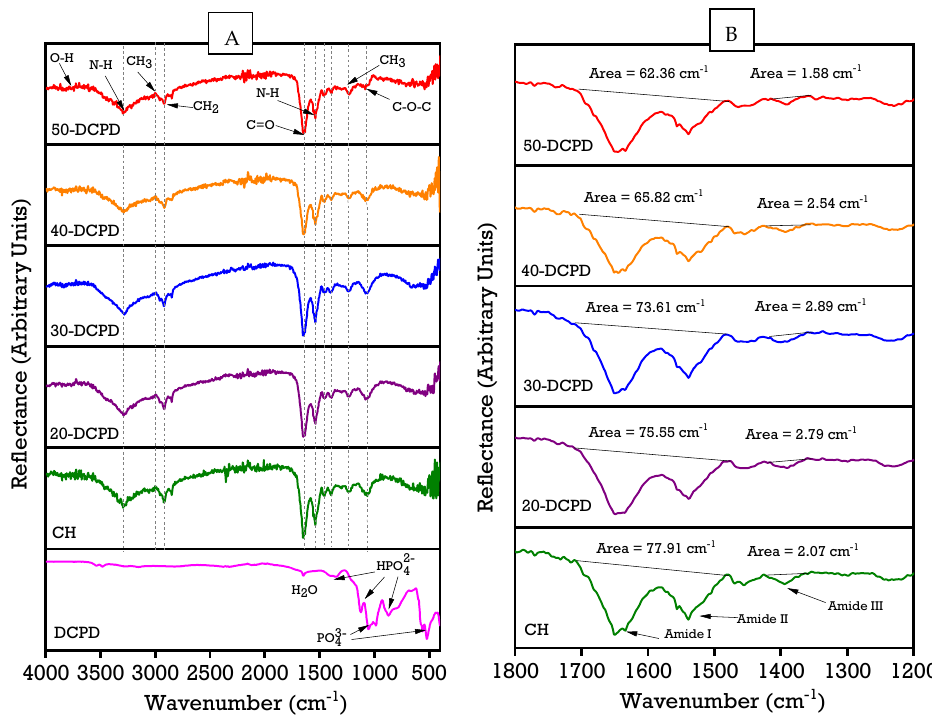
Figure 1. Comparison of Fourier transform infrared spectroscopy spectra of synthesised freeze-dried chitosan (CS) scaffolds containing varying concentrations of dicalcium phosphate dihydrate (DCPD) mineral (0, 20, 30, 40 and 50 (wt)% DCPD): ( A ) data obtained in the 400 cm −1 to 4000 cm −1 regions at a resolution of 4 cm −1 using the Vertex 70 FTIR spectrometer, USA, in attenuated total reflection mode; ( B ) comparison of the amide I, II and III peaks determined using OriginPro software.